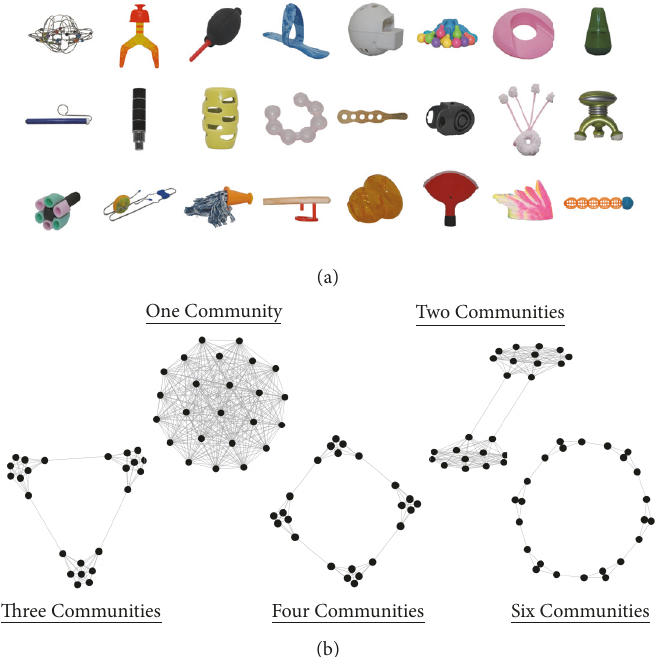
Figure 1: Representation of stimulus materials. Panel (a) visualizes the set of NOUN database complex objects assigned to each node in the graphspresented[21].Panel(b)visualizesthefivegrapharchitecturesusedtogeneratethecontinuousobjectstreams.Graphedgescorrespond to the transition from one object to another in